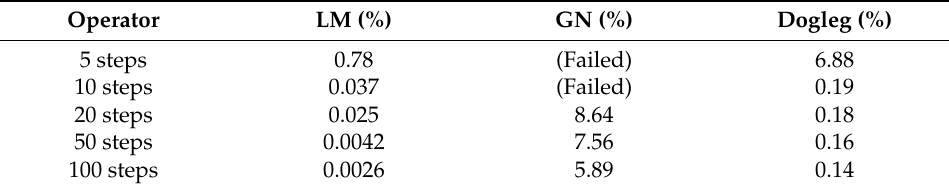
Table 3. Accuracy of three tracking operators in homotopy